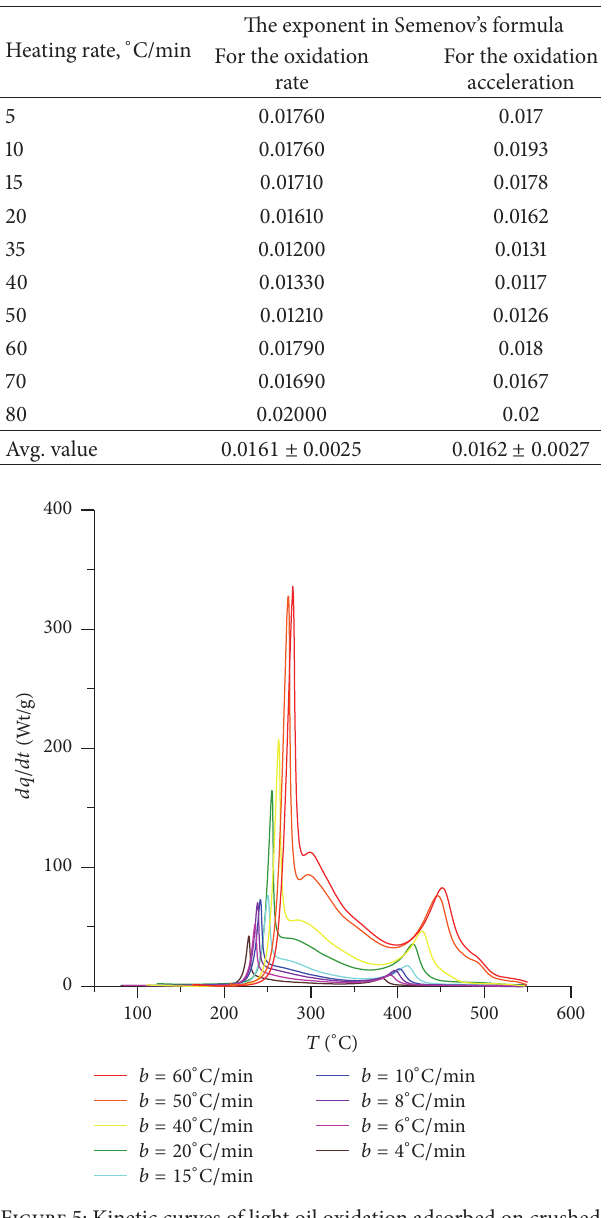
Table 2: The values of the exponent in Semenov’s formula for acceleration rate of oxidation reaction at the initial stage of the process.